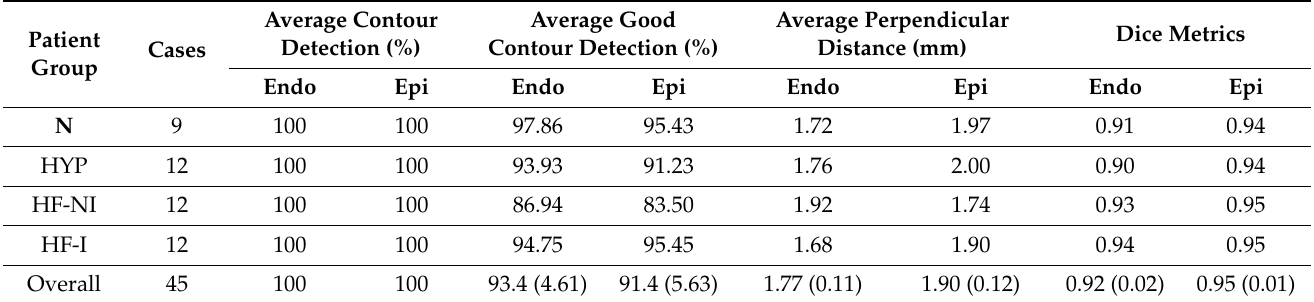
Table 8. Performance evaluation parameters for dice loss and Relu